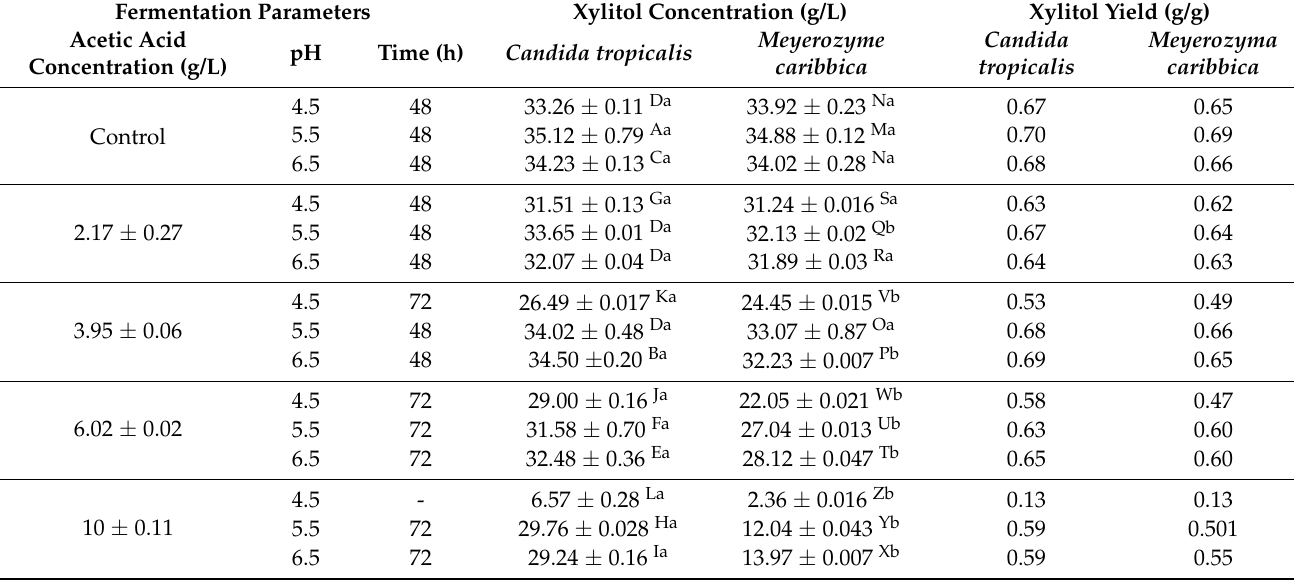
Table 2. Effect of acetic acid concentration in rice straw hydrolysate on xylitol production at different pH values by Candida tropicalis and Meyerozyma caribbica